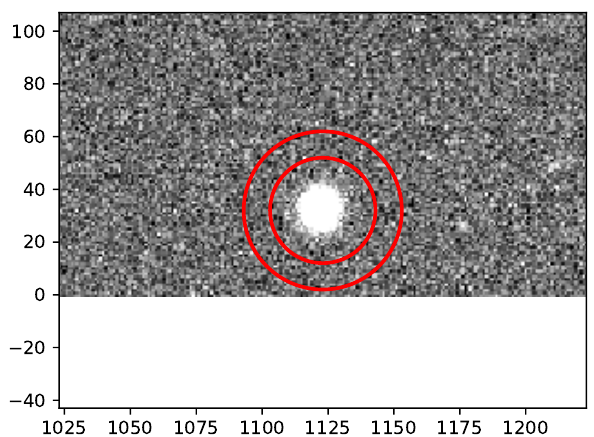
Fig. 99.— SDSS DR9 frame displayed with imshow